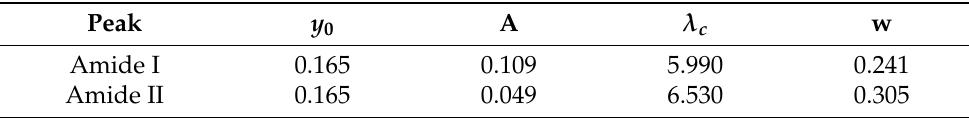
Table A1. The double-peak Lorentz absorption function parameters of extinction spectra enhanced by bilayer